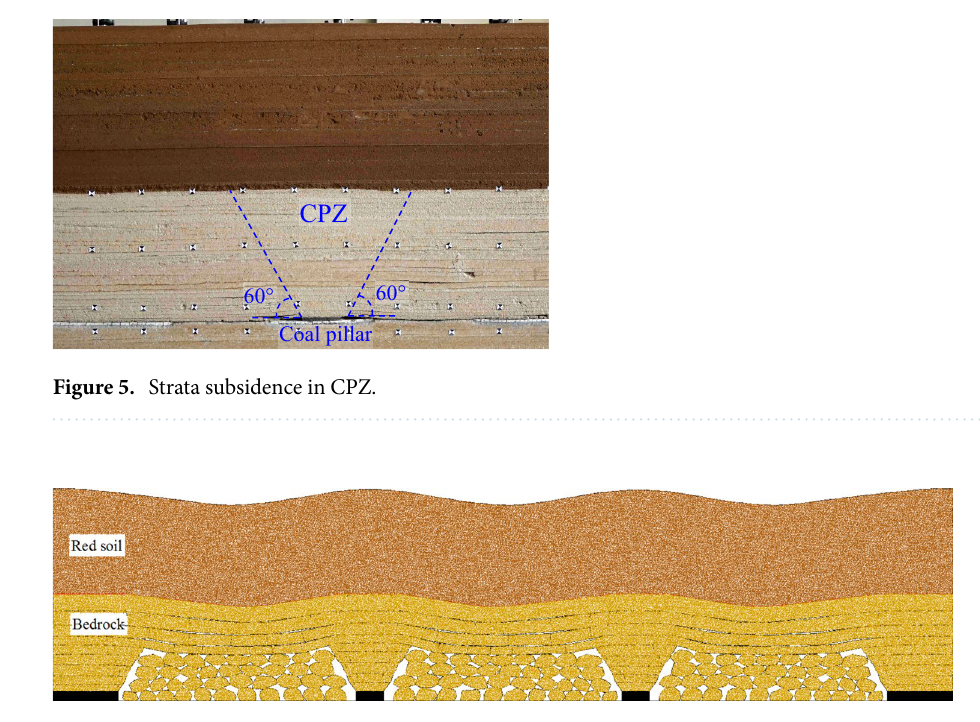
Figure 6. Movement and subsidence of overburden strata in dip direction.